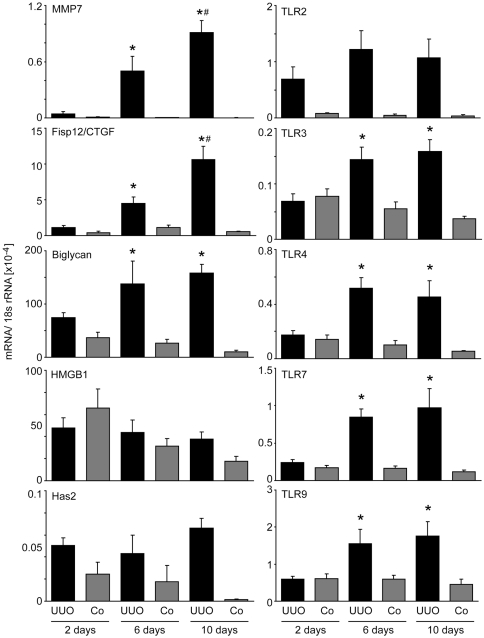
TLR and TLR agonist mRNA expression after UUO.Wildtype mice underwent surgery and UUO kidneys (black bars) or contralateral kidneys (Co, grey bars) were harvested at different time points after surgery as indicated. mRNA expression levels were determined by real-time RT-PCR and related to the respective 18S rRNA expression. Data are expressed as means ± SD. * p<0.05 versus wildtype of the same time point, # p<0.05 versus time point day 2.